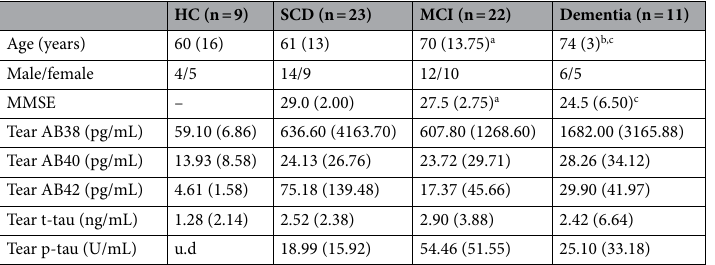
Table 1. Demographic and clinical characteristics and tear biomarkers of the total group. Data are shown as median (interquartile range). u.d undetectable, MMSE Mini-Mental State Examination. a p < 0.01 SCD vs MCI,